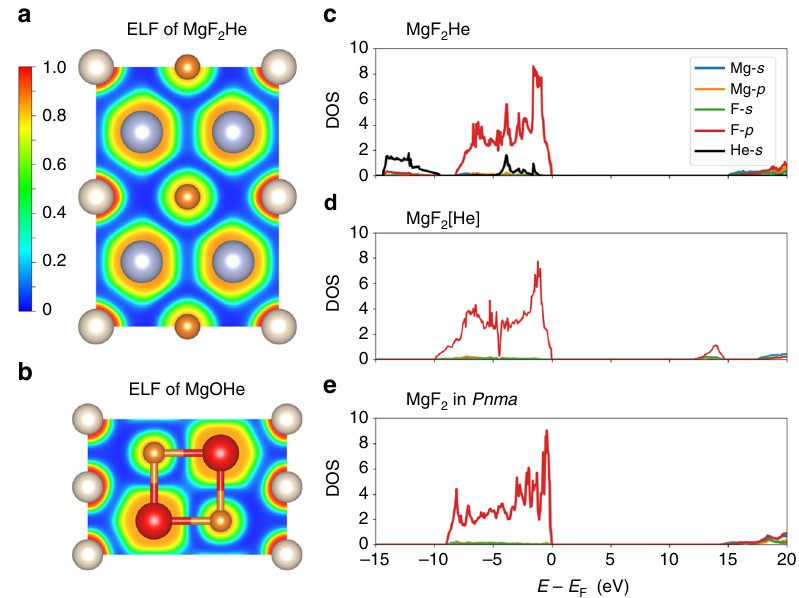
Fig. 3 Electronic structures of MgF 2 He and MgOHe. a ELF in the (110) plane of MgF 2 He- Fm 3 m . b ELF in the (100) plane of MgOHe- P 6 3 /mmc . c